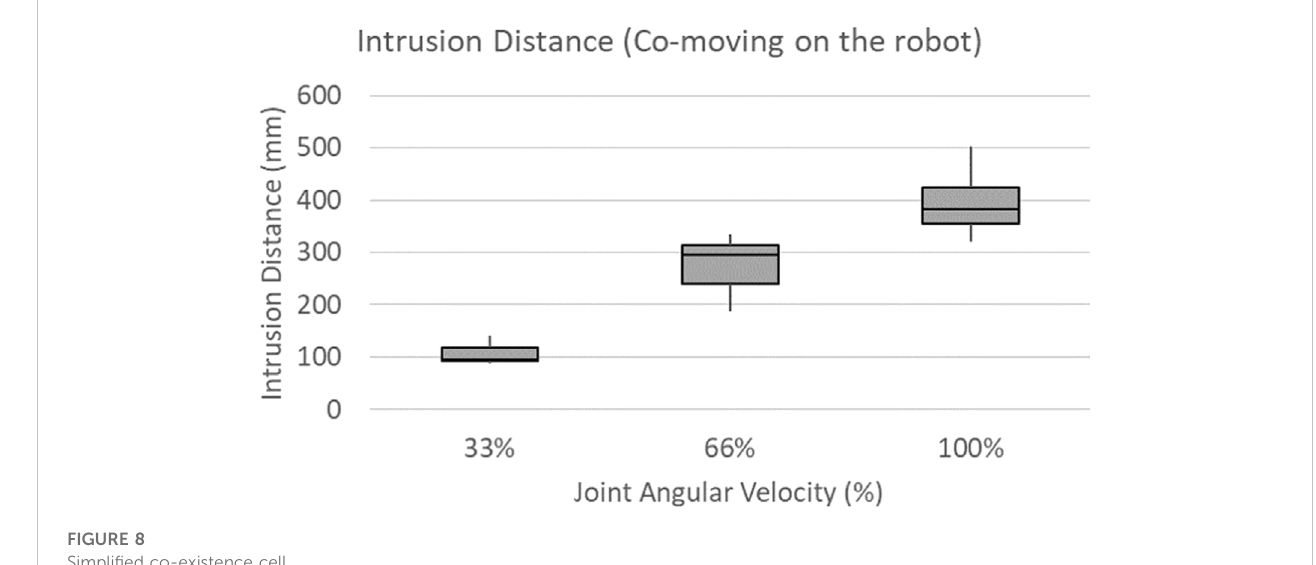
FIGURE 8 Simpli fi ed co-existence cell.